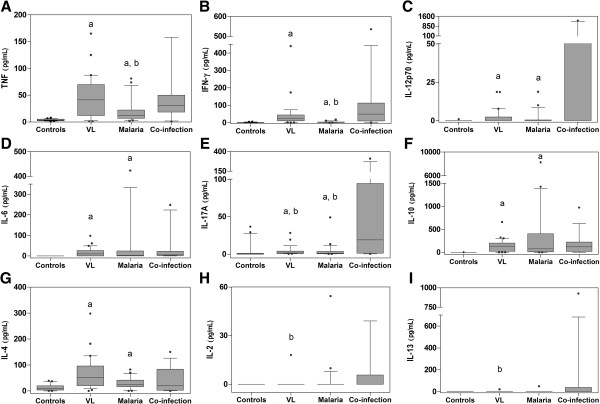
(A-I) Cytokines from healthy individuals (Controls) and patients with VL and/or malaria. Cytokine levels in each group (see Additional file 1 for detailed data) are shown as median and interquartile range (box), with 10th and 90th percentiles (whiskers). Letters (a) and (b) above the box-plot indicate statistically significant differences (P <0.05) as compared with the healthy controls and the co-infected patients, respectively.